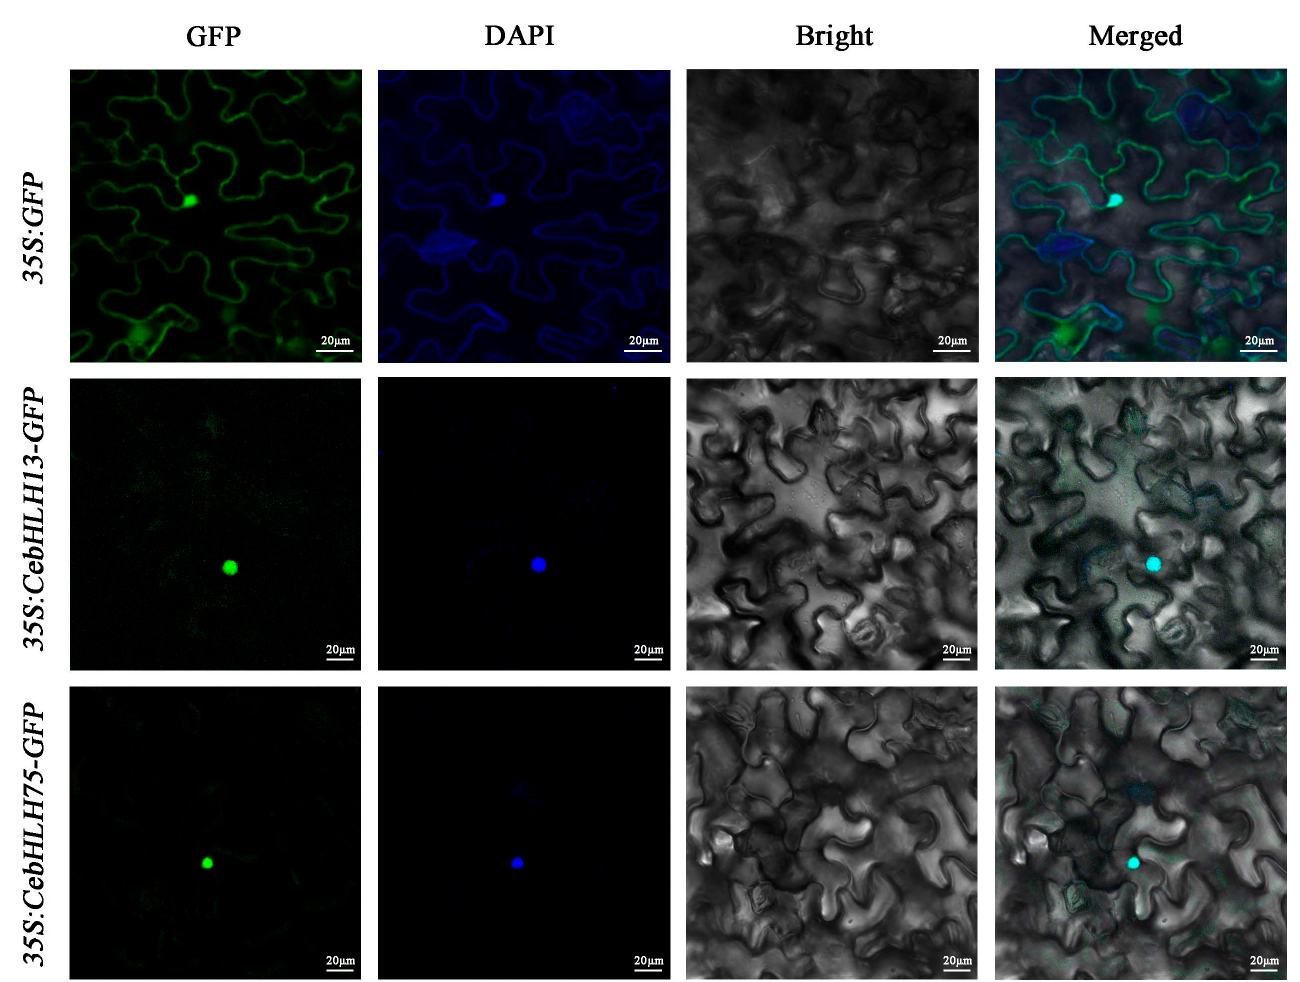
Figure 9. Subcellular localization a nalysis of CebHLH13 and CebHLH75 proteins.